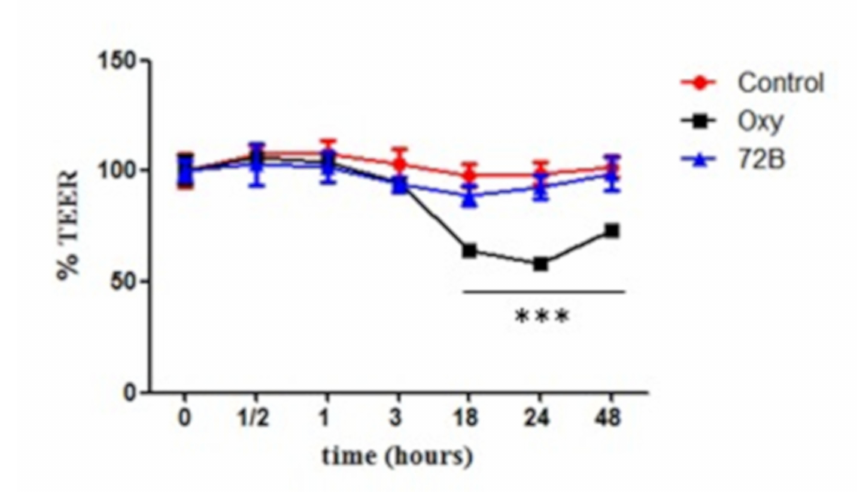
Figure 5. Determination of transepithelial electrical resistance (TEER). Caco-2 cell monolayers were incubated for 48 h with 72B extract (blue triangles), an oxysterol mixture as a prooxidant agent (Oxy, black squares) and positive CTRL (only solvent, red circles). The TEER value was measured at di ff erent time points to see any significant changes in monolayer permeability. Statistically significant di ff erences are expressed (*** p < 0.001). Each value represents the mean ± SD of independent experiments ( n =